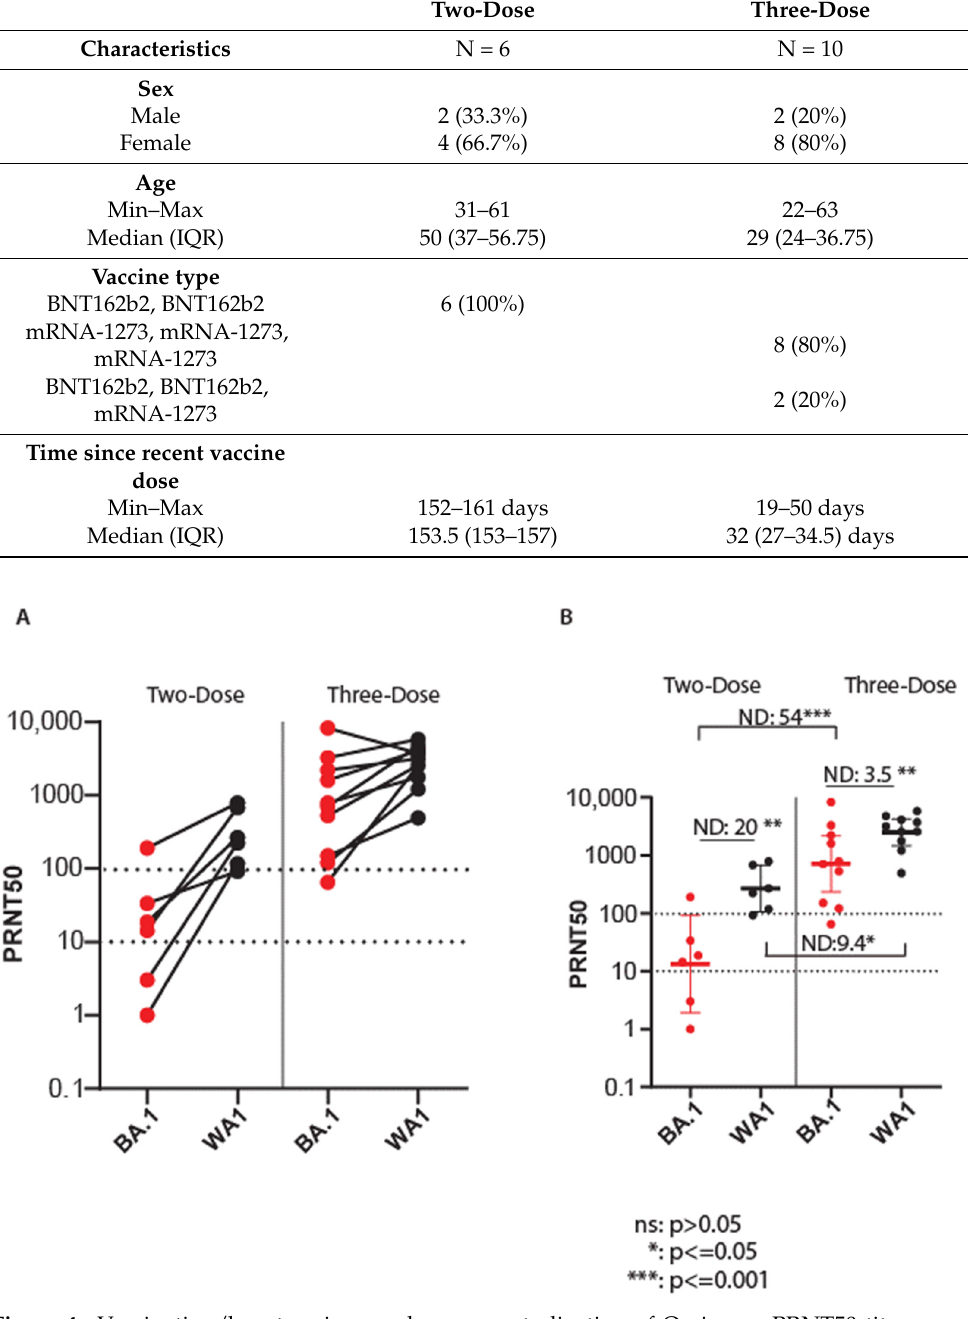
Figure 4. Vaccination/boost regimen enhances neutralization of Omicron. PRNT50 titers were determined from serum samples from SARS-CoV-2 naïve individuals who received the vaccination two-dose regimen (Pfizer vaccine) or three-dose vaccine regimen (Moderna or Pfizer with Moderna boost; Table 3). Neutralization of SARS-CoV-2/WA-1 and the Seattle Omicron BA.1 variant was determined by side paired testing. ( A ). Geometric mean and standard deviation PRNT50 titers of individual sera in paired testing against each virus. ( B ). PRNT50 data of serum analyses showing geometric mean and standard deviation, with all input data points. Neutralization difference (ND) values are shown. PRNT50 values were statistically evaluated using paired t -test. Significant differ- ences are indicated with the p -value. Ns: nonsignificant. The PRNT50 10 lower limit neutralization value and 100 value are marked by the dotted lines. ns: p > 0.05, *: p <= 0.05, ***: p <= 0.001.